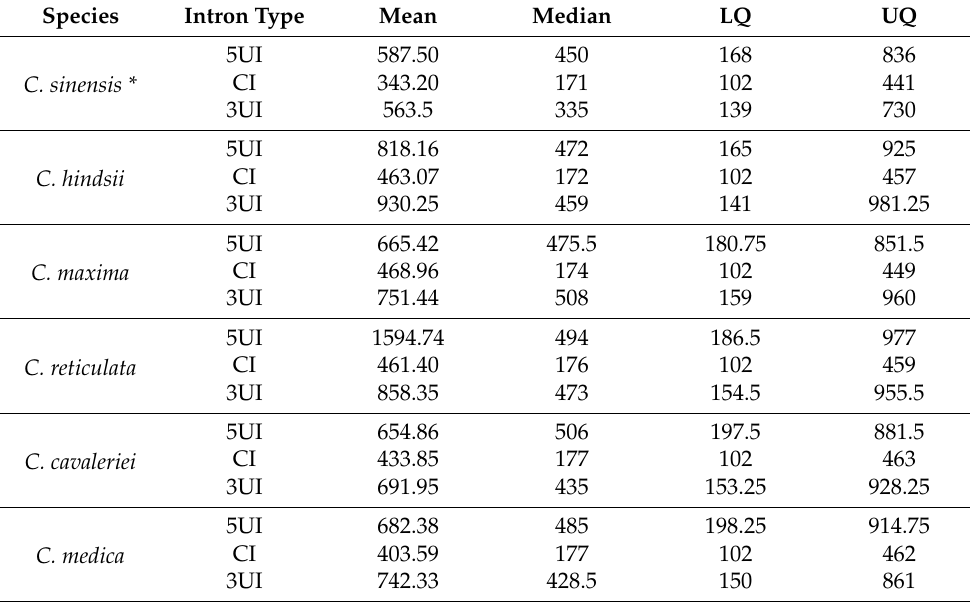
Table 2. Summary statistics for intron lengths in 5 (cid:48) UTR, 3 (cid:48) UTR and CDS in six citrus species. CI: CDS intron; LQ: lower quartile; UQ: upper quartile. *: cited from reference [28].